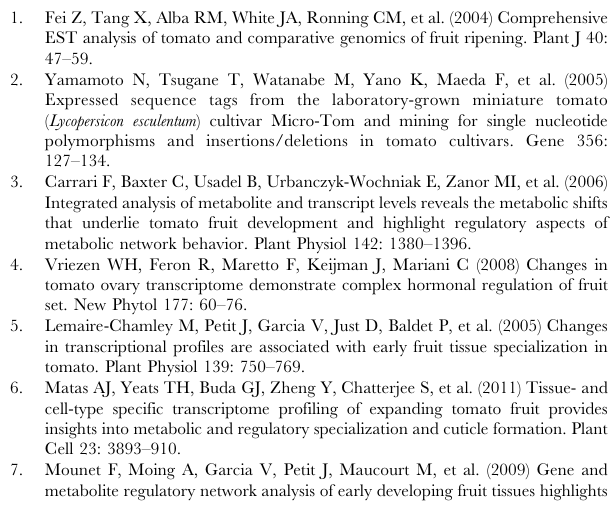
Figure S1 Exon/intron organization of the tomato SlPPC2 gene. The tomato SlPPC2 gene (GenBank accession